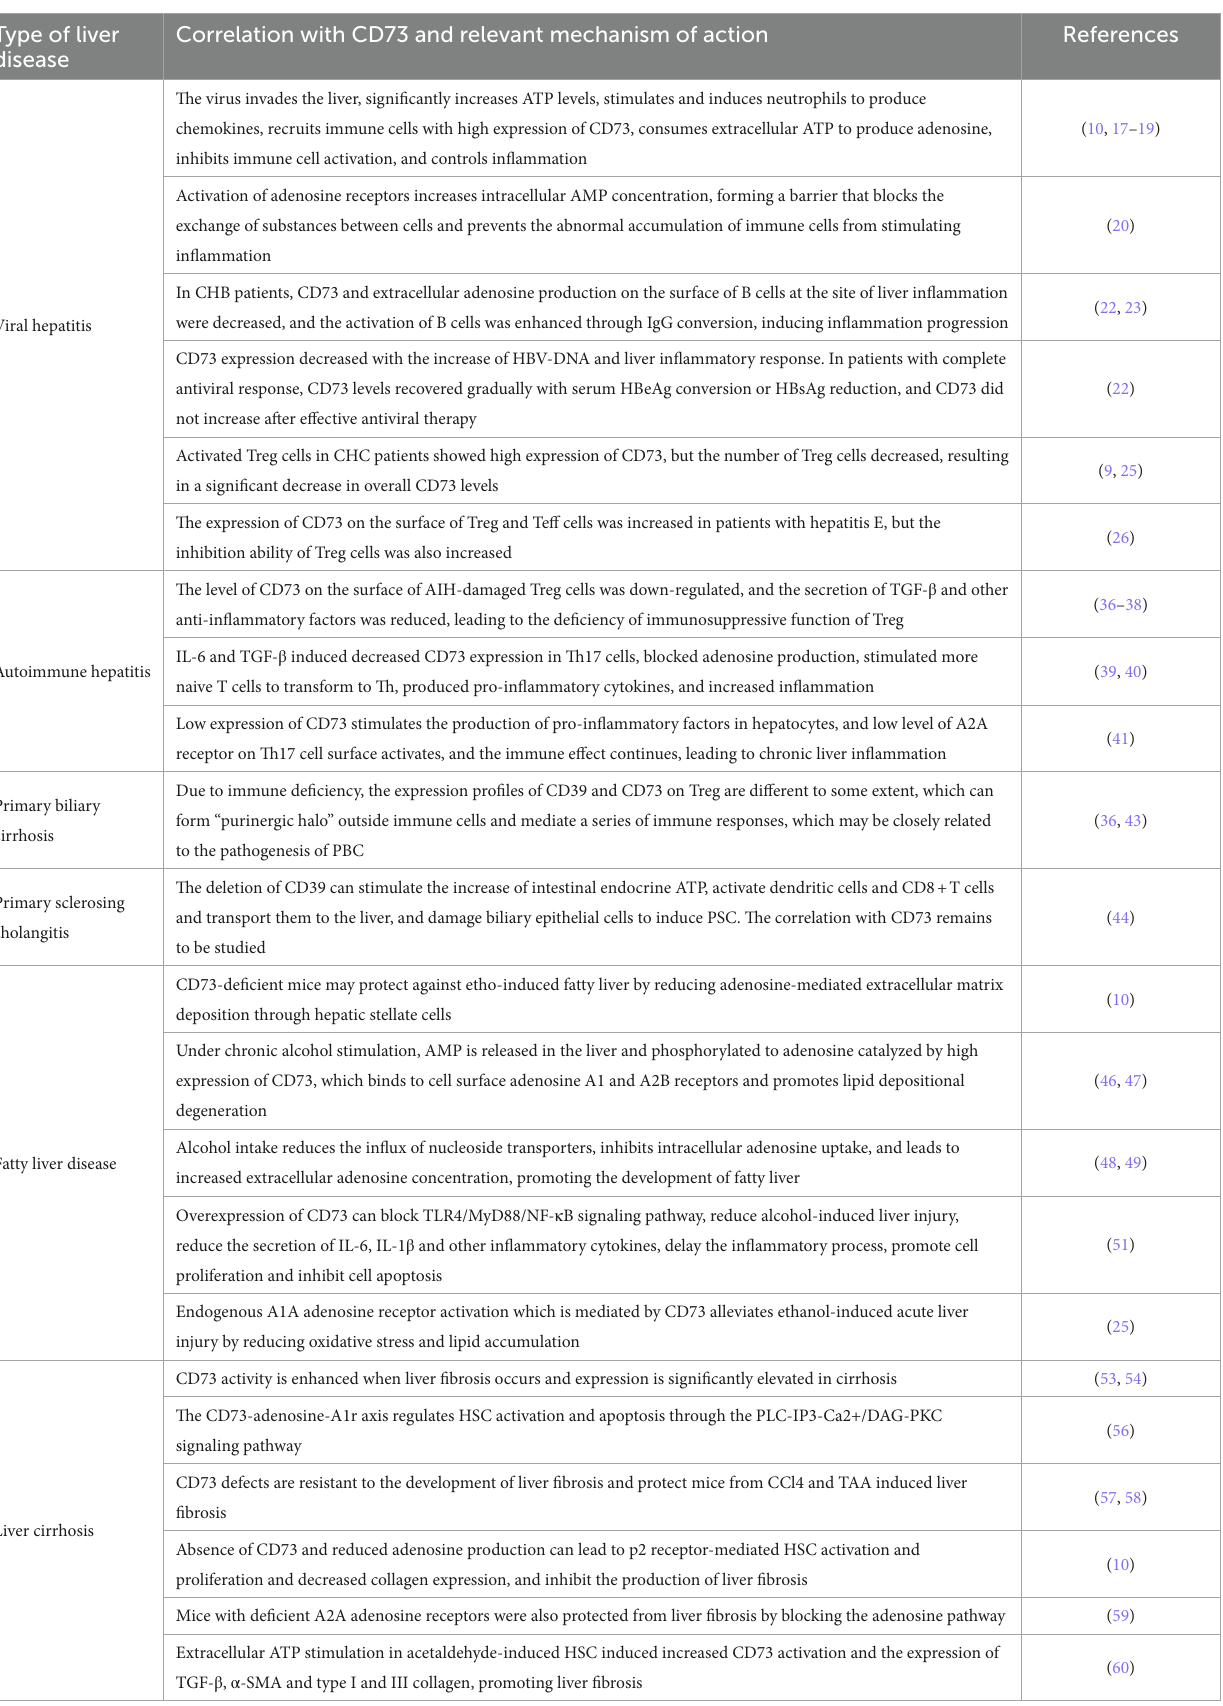
TABLE 2 List of related mechanisms of CD73 in liver diseases. Type of liver Correlation with CD73 and relevant mechanism of disease